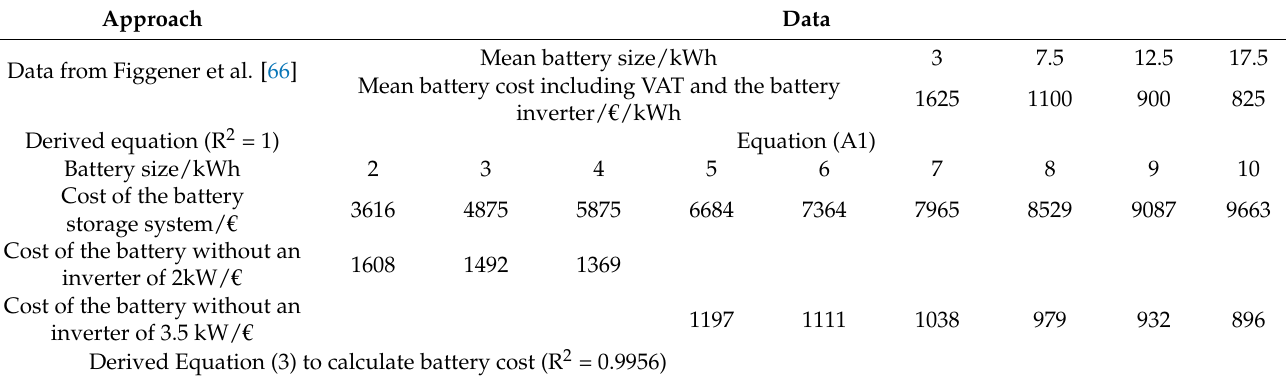
Table A2. Calculation of the batter cost per kWh: The battery cost function was derived using data from Figgener et al. [66]. These already include the VAT and the inverter costs. The approach is described in the table. In the first step, the data from Figgener et al. was fitted (see Equation (A1)). For all battery sizes between 2 kWh and 10 kWh, the inverter costs are then subtracted from the battery system costs. According to Figgener et al. [66], the average inverter size for storage systems between 5 kWh and 10 kWh is 3.5 kW. The inverter costs are assumed to be 200 € /kW. Thus, for the calculation, for all batteries larger than 5 kWh 700 € was deducted from the storage system costs. For all systems smaller than 5 kWh, only 400 € were deducted for an inverter with a size of 2 kW. From this a functional relationship can be derived, which is represented by Equation (3). The coefficient of determination is 0.9956.